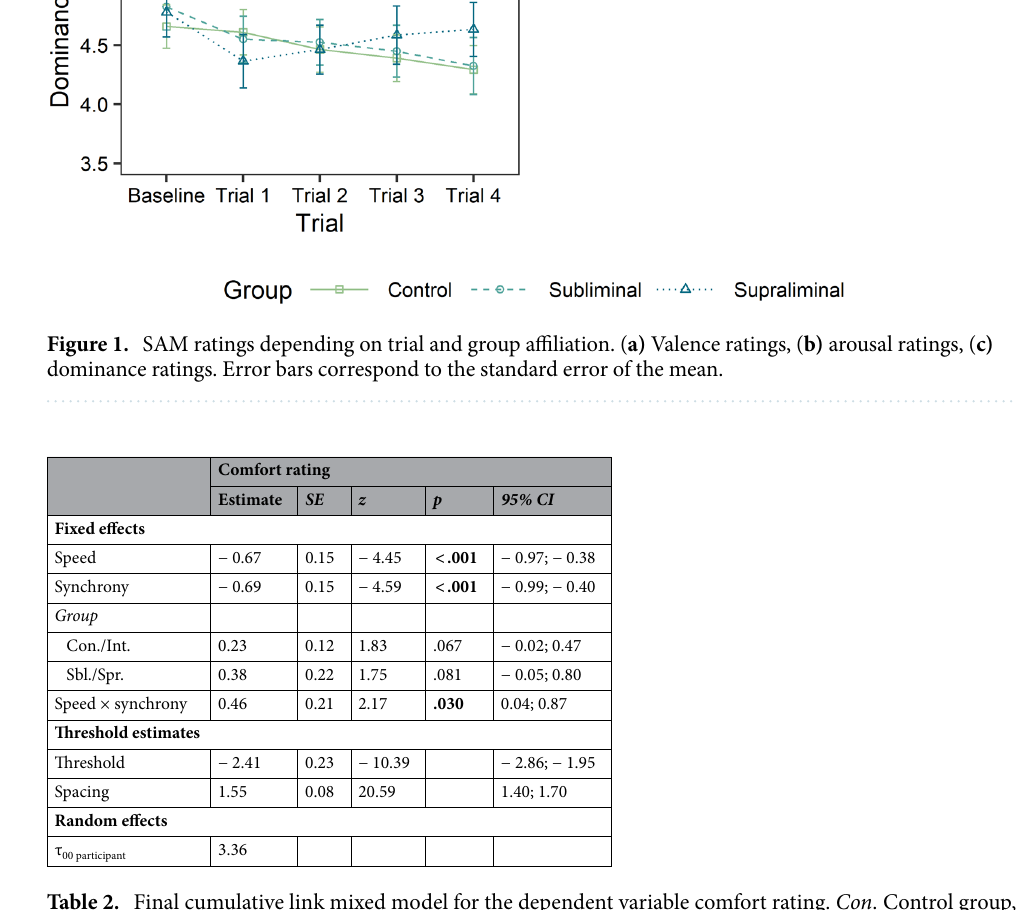
Table 2. Final cumulative link mixed model for the dependent variable comfort rating. Con . Control group, Int. Intervention, Sbl. Subliminal group, Spr. Supraliminal